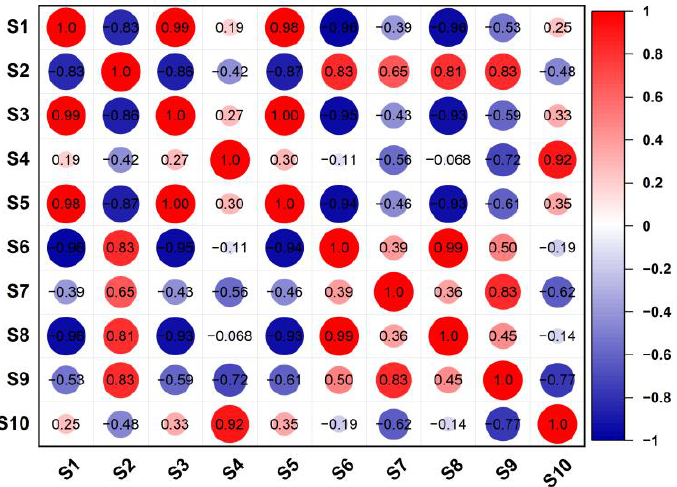
Figure 2. The means and standard deviations of the e-nose sensor signals for each leachate sample. The Pearson correlations between e-nose sensor signals are displayed in Figure 3. The 10 sensors showed different correlations. S1 had high correlations (positive or negative) with S2, S3, S5, S6, and S8. S1 had high correlations with S1, S2, S3, S5, S6, S7, S8, and S9. These correlations were observed frequently among the e-nose sensors, suggesting that the headspace gas information could be detected by all sensors but may have overlapped.